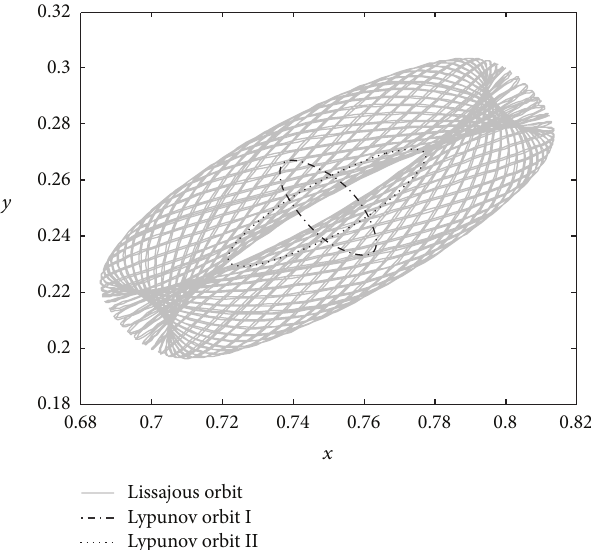
Figure 7: Stable Lissajous orbit and Lyapunov orbits near the sail equilibrium: 𝐺 1 = 20, 𝐺 2 = 10, 𝐺 3 = 10